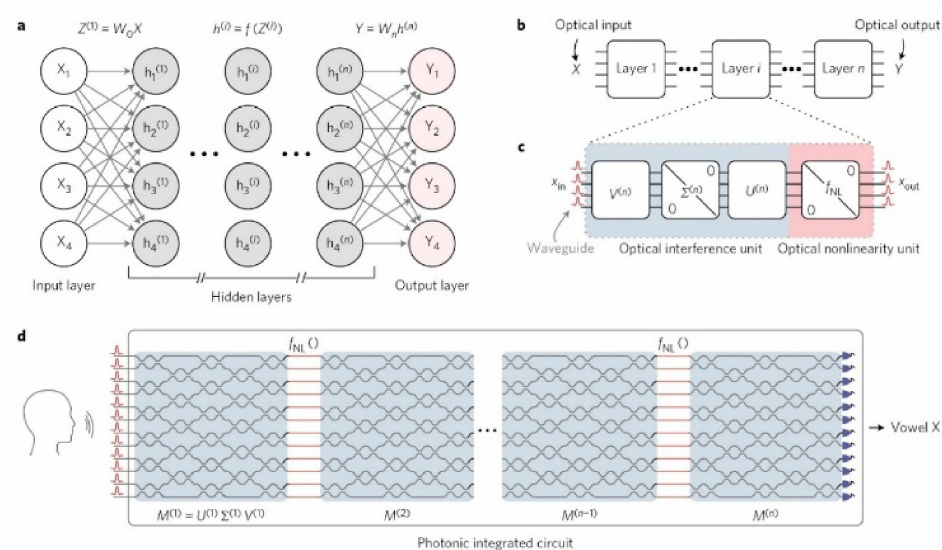
Figure 5. Nanophotonic multilayer perceptron architecture: ( a ) A typical NN with its input–output layers and n hidden layers. ( b ) Hidden layers in optical implementation. ( c ) The optical units in each hidden layer. ( d ) The final arrangement in an integrated circuit